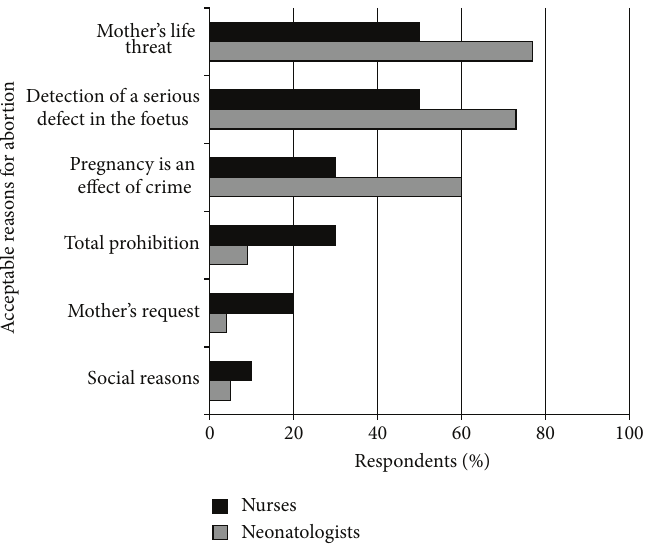
Figure 1: Reasons for abortion acceptable by respondents.